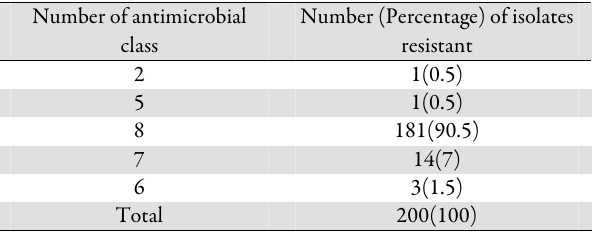
Table 5. Number of antimicrobial class to which methicilin-resistant staphylococcal isolates from broilers were resistant Number of antimicrobial